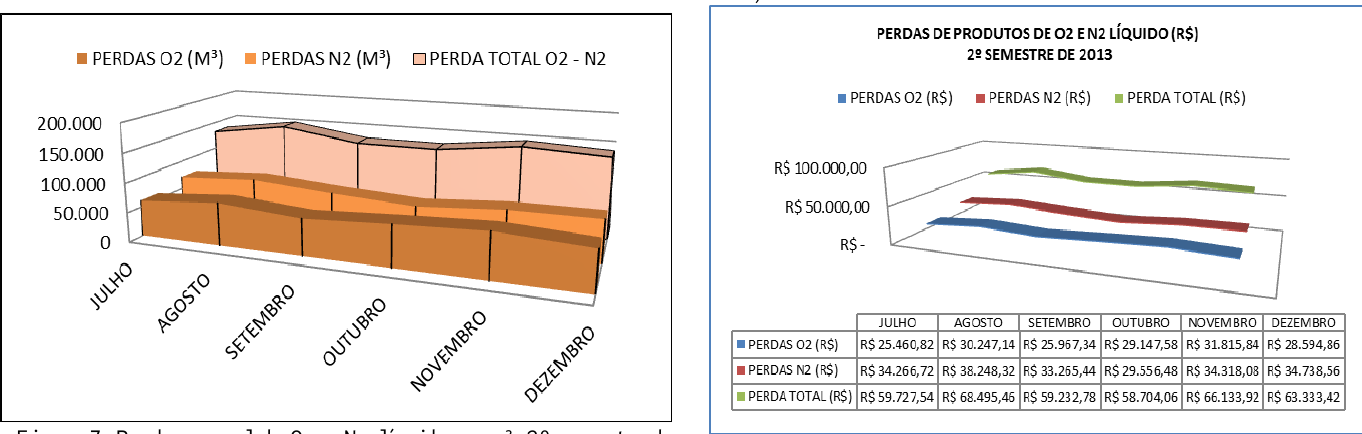
Figura 9. Perdas de produto O